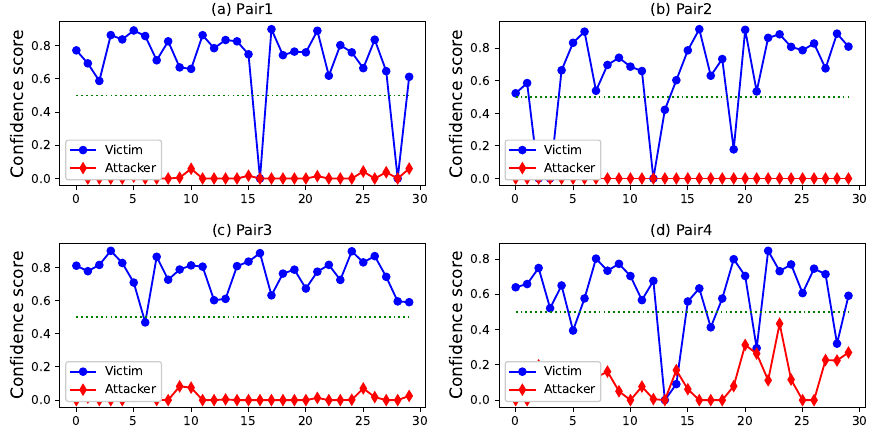
Figure 5. Best-performing attacker–victim